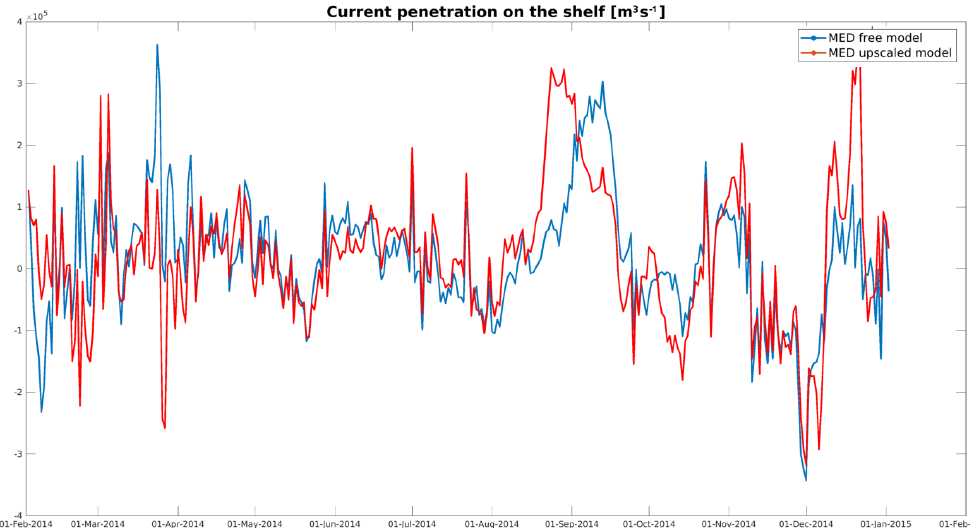
Figure 6. Water transport across the shelf break during 2014, as obtained by the free (blue curve) and upscaled (red curve) parent models. Positive values indicate a net on-shelf transport.